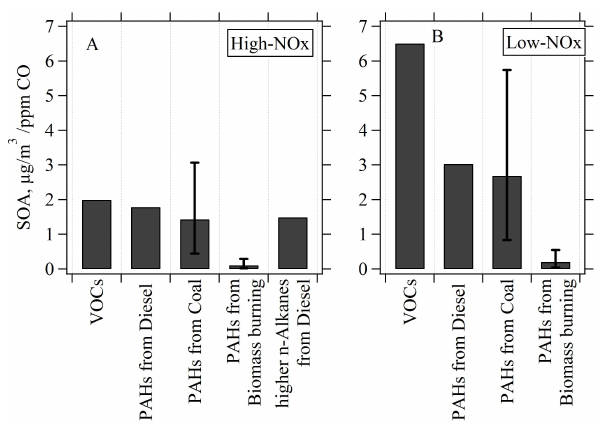
Fig. 8. Comparisons of SOA formation from VOC oxidation, and from PAHs and higher n-alkanes using emission factors of various sources after 50 h oxidations under both high-NO x (A) and low- NOx (B) conditions. Error bars in the PAH contributions of coal burning and biomass burning represent the highest and lowest cal- culated values from different types of coals or crop